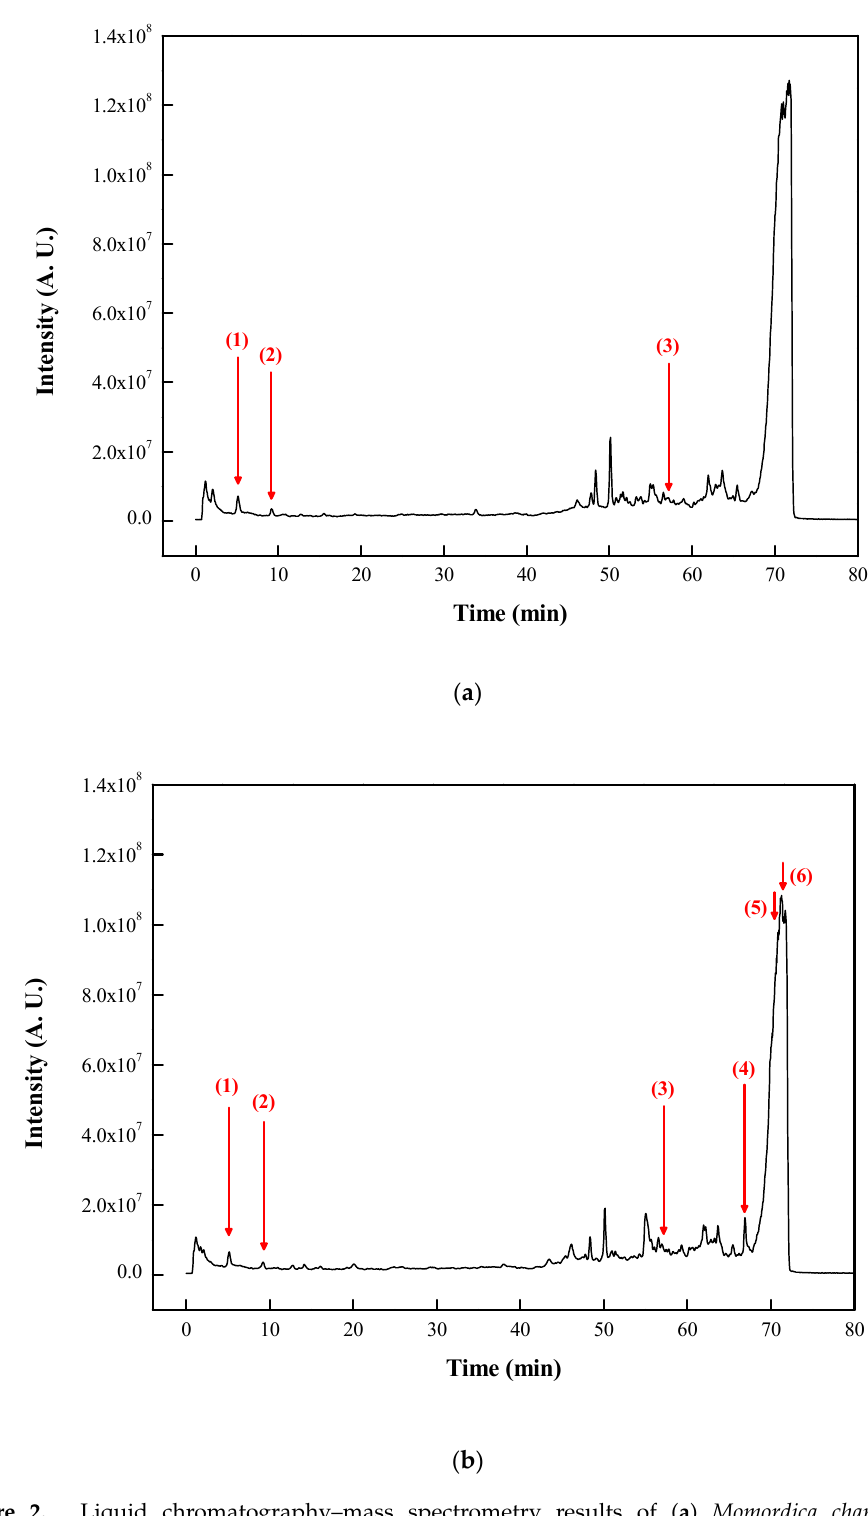
Figure 2. Liquid chromatography–mass spectrometry results of ( a ) Momordica charantia L. and ( b ) Momordica charantia L. var. abbreviata Ser. juice. Identified components included (1) phenylalanine; (2) tryptophan; (3) balsaminoside C; (4) goyaglycoside G; (5) vicine; and (6) momordicoside Q.